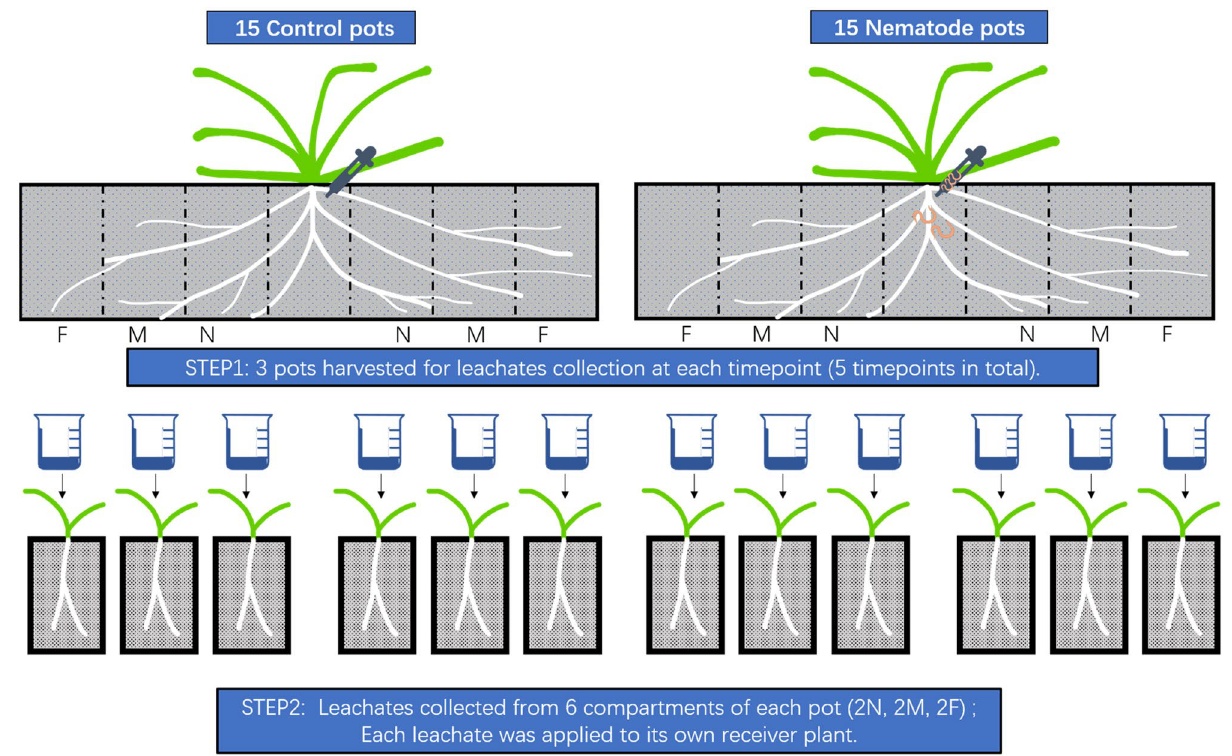
Figure 1. Schematic diagram of the experiment: Step 1 indicates three pots were randomly selected from the control and nematode-treated group at each timepoint to collect leachates from harvested samples of root and soil at 5–15 cm (N),15–25 cm (M) and 25–35 cm (F) distance away from the central donor plants (nematode inoculum addition as treatment and water addition as control); Step 2 indicates that leachates were collected from the harvested sample and were then applied to receiver plants. Each distance had 6 receiver plants as replicates at each sampling timepoint for each treatment group (3 pots* 2 sides). The response variables measured in the receiver plants were root, shoot, and total biomass, root/shoot ratio, shoot height, shoot tiller number, rooting depth and root